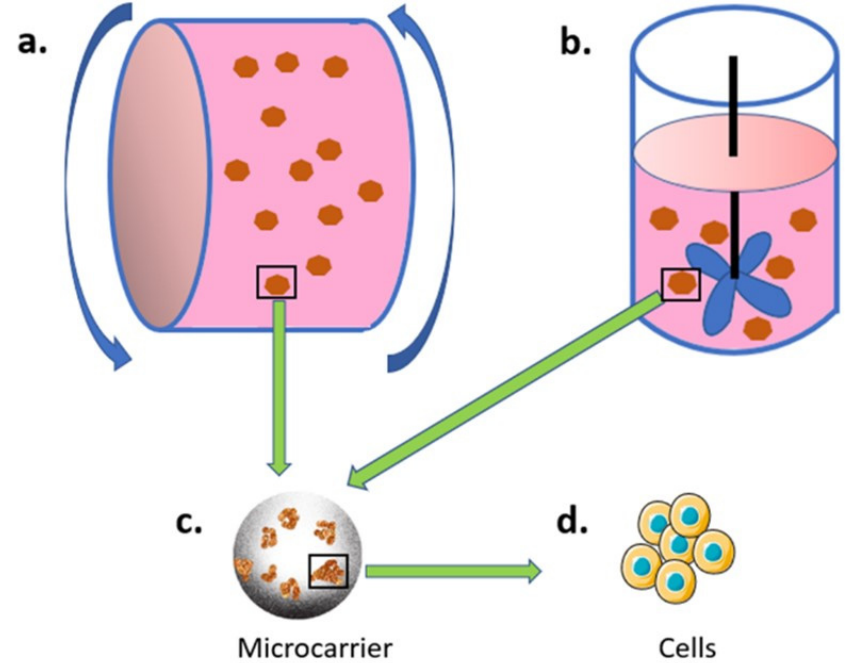
Figure 1. Bioreactor and microcarrier-based culture system. Microcarrier ( c ) are used for cell ( d ) adhesion, and the cell-loading microcarriers are then placed in either ( a ) rolling or ( b ) spinning bioreactors. The most significant advantage of the microcarrier is that it economically suits the large-scale cell culture. A well-known example of microcarriers in large-scale production is the production of inactivated or live attenuated virus vaccines with the Vero cell line, which has been commonly used to produce many vaccines, including some SARS-CoV-2-based vaccines [112]. In addition, microcarriers are widely used in stem cell expansion for stem cell therapy [113–115], including the expansion of human mesenchymal stem/stromal cells (MSC) and induced pluripotent stem cells (iPSC). Stem cells expanded by microcarriers show advantages not only in the large-scale with a relatively low cost but also in the quality and reliability of the stem cells, including less heterogeneity [116] and better function in the downstream applications [117–119], compared to the ones expanded by the 2D cell culture systems. In addition, differences in morphology, surface markers, gene expression profiles, and secretome are observed between the microcarrier and conventional 2D systems in the stem cell culture [116,120]. The other characteristic of microcarrier cell culture is that cells can go through a bead-to-bead transfer [121], which simplifies the subculture process in the large-scale production of stem cells. In addition to large-scale production, microcarriers can also serve as a vehicle for cell delivery in tissue regeneration, especially in bone and cartilage tissue engineering. For example, injectable microcarriers have been developed to carry cells to repair and reconstruct irregular defects in a minimally invasive manner